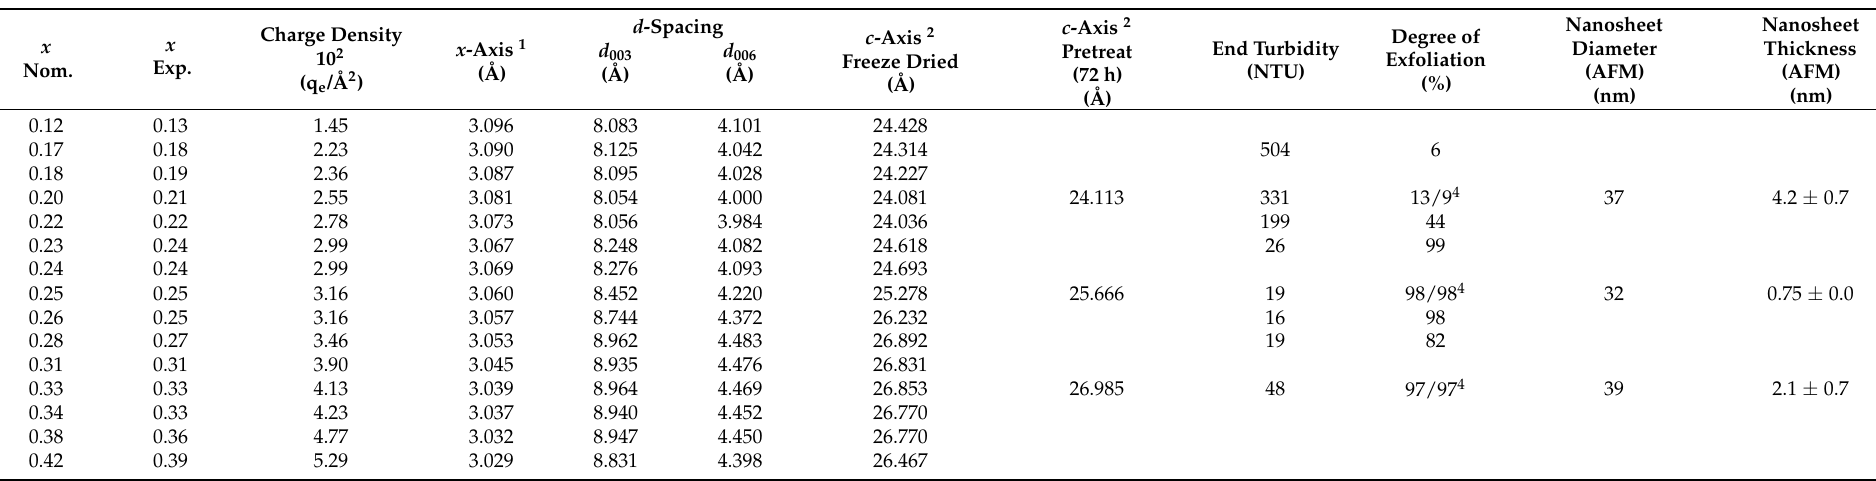
Table 1. Composition, layer charge, unit cell dimensions, and exfoliation properties of Mg 1 − x Al x (OH) 2 (NO 3 ) x · m H 2 O; x = 0.12–0.42. x Nom.